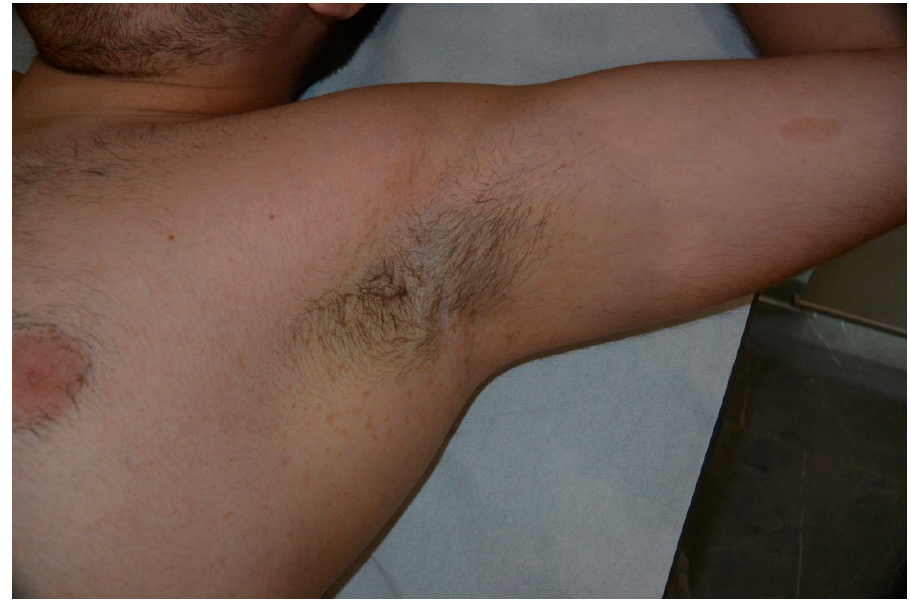
Figure 6. Crowe sign with extensive freckling of axillae in a patient affected by NF1.